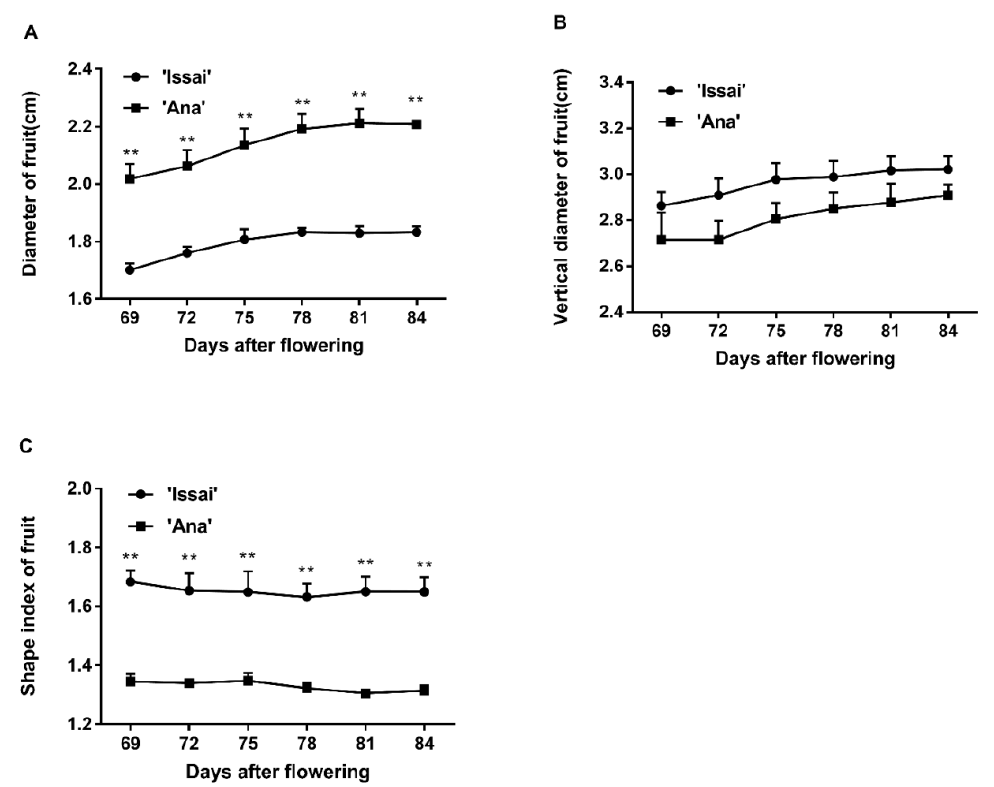
Figure 2. The effect of maturity stage at harvest on changes in diameter ( A ), vertical diameter ( B ), and shape index ( C ) of the fruit. Data are presented as mean ± standard error from three biological replicate assays (** p < 0.01). The error bars represent standard error of the means.